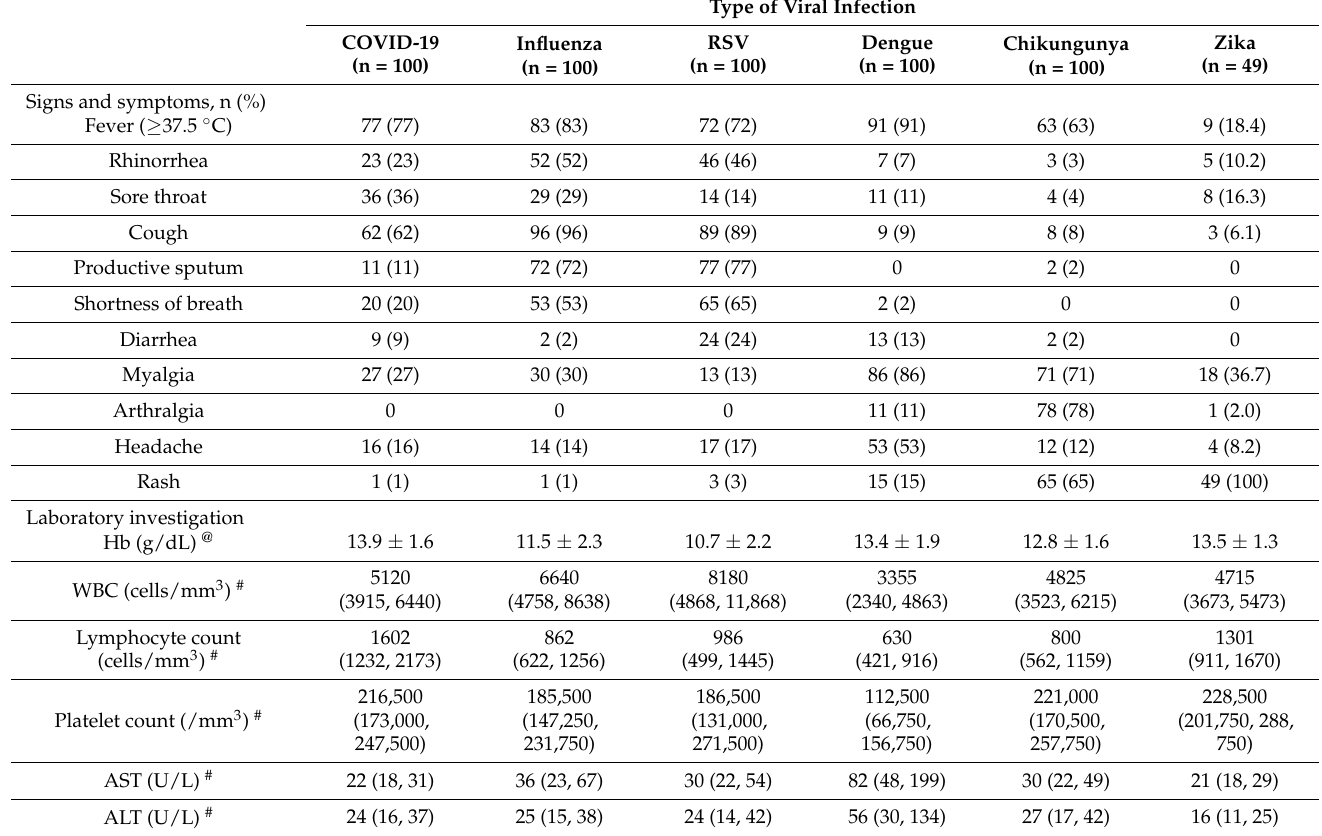
Table 2. Clinical presentations and laboratory findings by type of viral